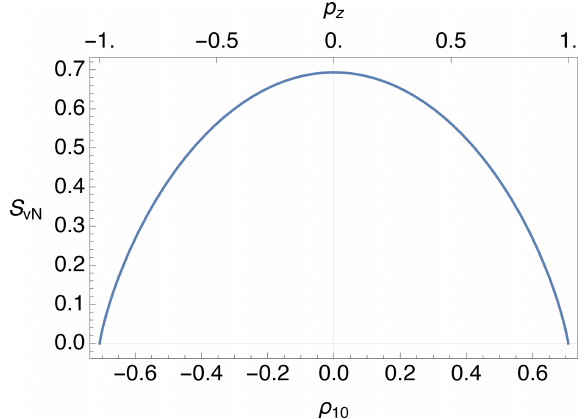
Figure 5. von Neumann entropy S vN plotted against the rank-1 po- larization moment ρ 10 and the z polarization p z for isolated spins- 1/2, for the case of zero transverse polarizations p x = p y = 0. The maximum value of S vN is ln2 (cid:39) 0 . 693. Figure 6. The von Neumann entropy S